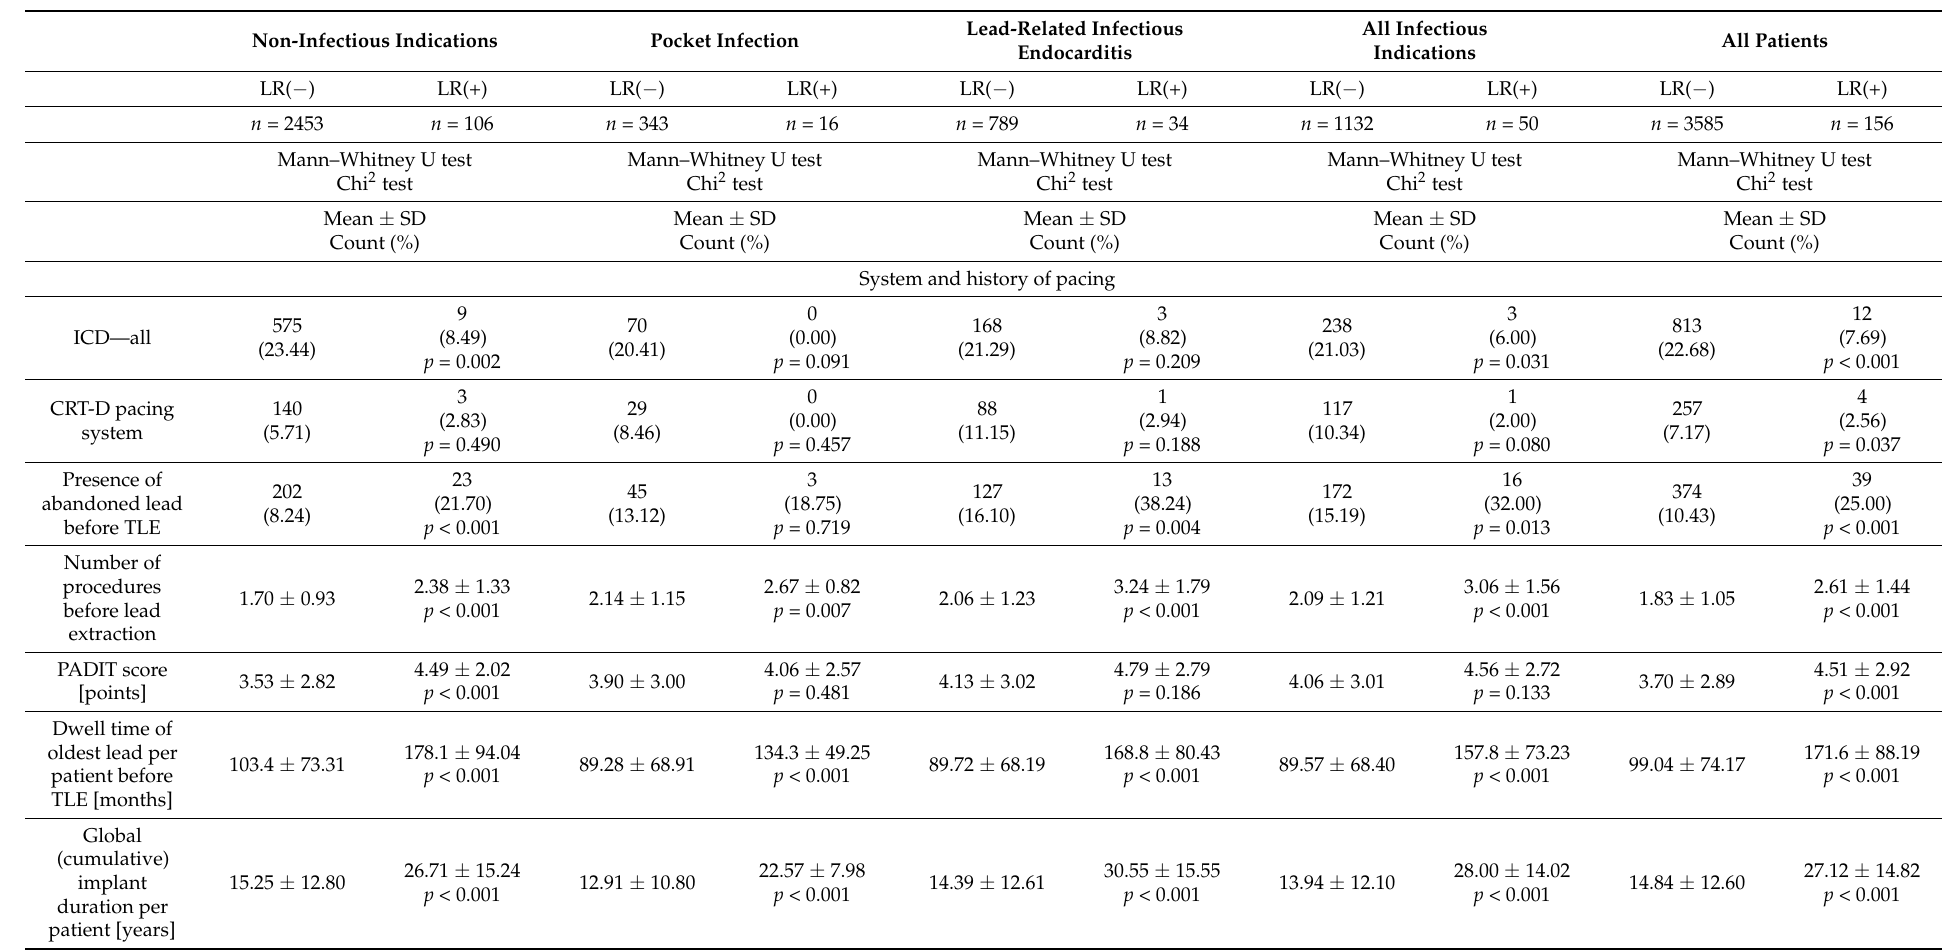
Table 2. System and history of pacing, procedure-related risk factors and predictors of major procedure complications and complexity. Lead-Related Infectious Non-Infectious Indications Pocket Infection